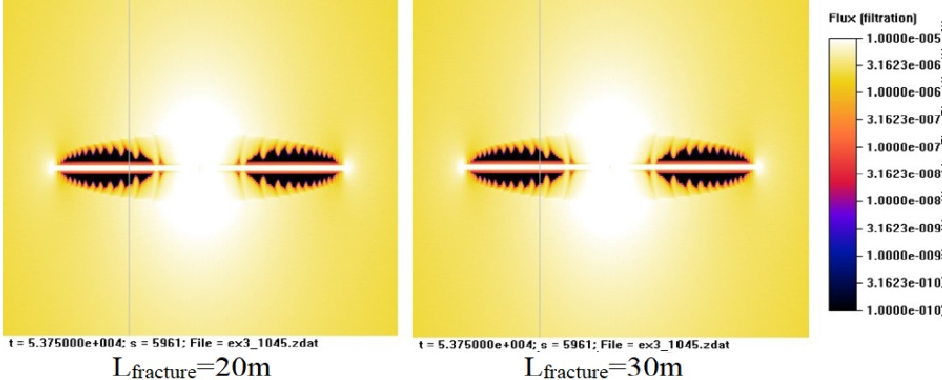
Figure 29. Oil seepage velocity in approximately 15 h after the start of cleaning.